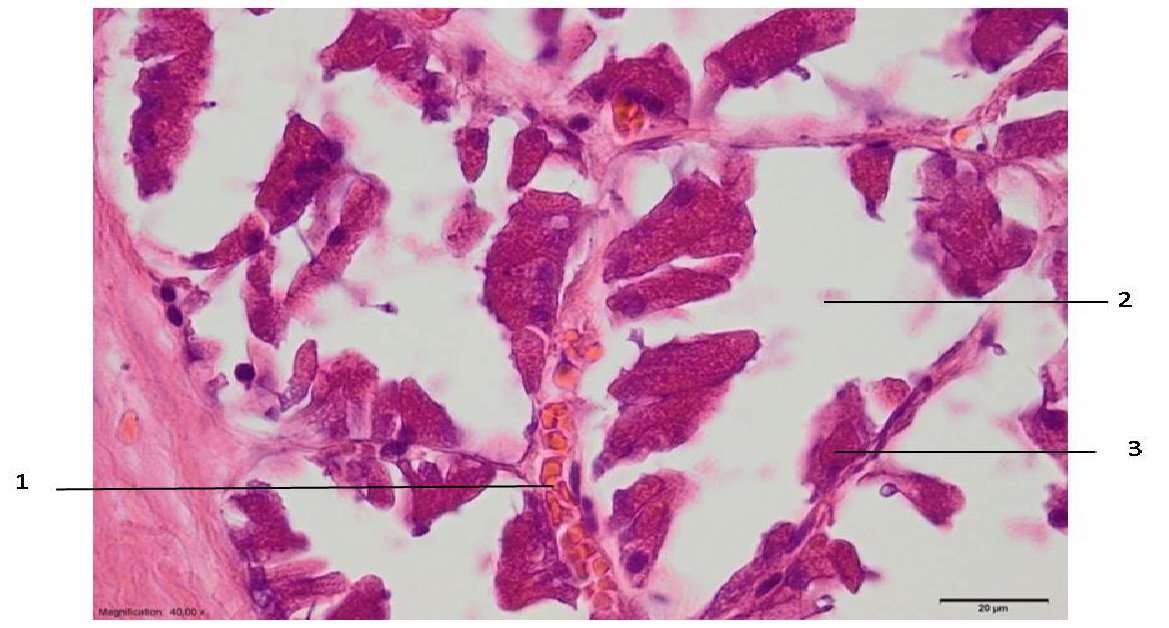
Figure 4. Zone IV of the prostate lesion: 1—dilated blood vessels; 2—prostate epithelium; 3—eosinophilia of secretory cell cytoplasm. Microtome-cut sections of prostate samples were stained with hematoxylin and eosin.